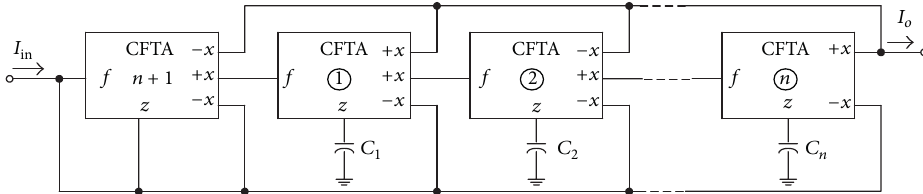
Figure 5: CFTA-based realization of n th-order current-mode all-pass filter, corresponding to the SFG given in Figure 3.